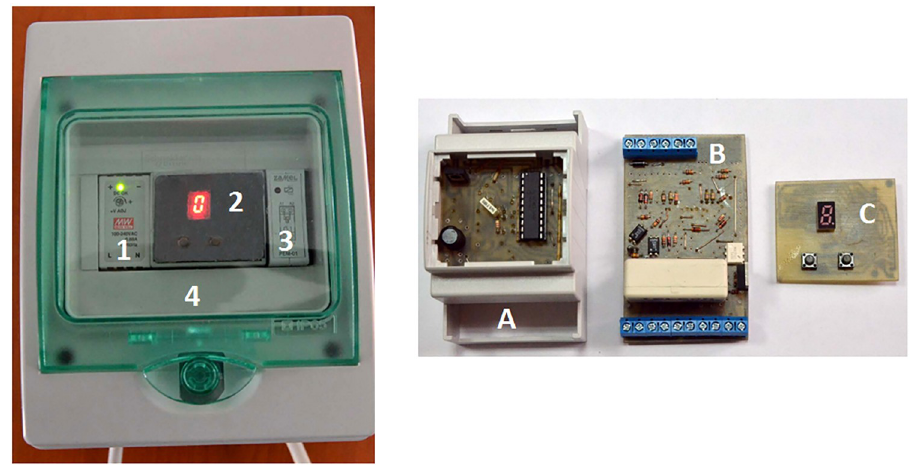
Fig 1. The power system protection